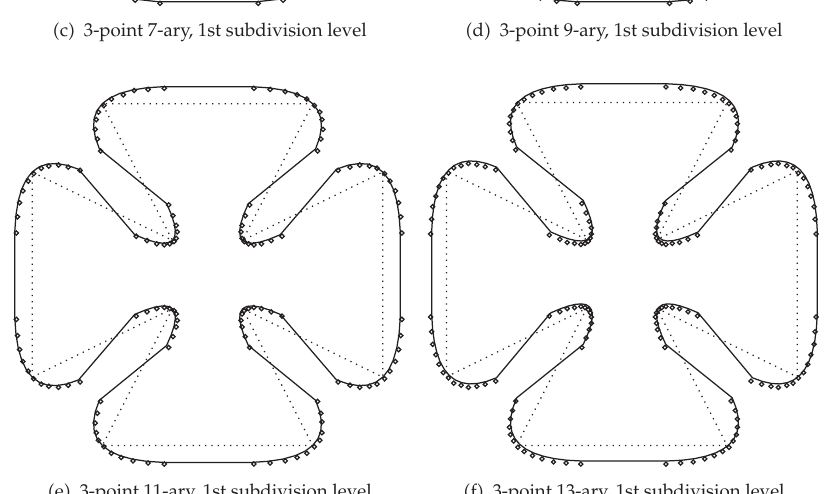
Figure 1: Dotted lines indicate original control polygon while continuous curves are generated by 3-point interpolating 3-ary, 5-ary, 7-ary, 9-ary, 11-ary, and 13-ary schemes (cid:2) 3.15 (cid:4) – (cid:2) 3.19 (cid:4) and (cid:2) 3.21 (cid:4) . Small squares indicate newly inserted points after first subdivision